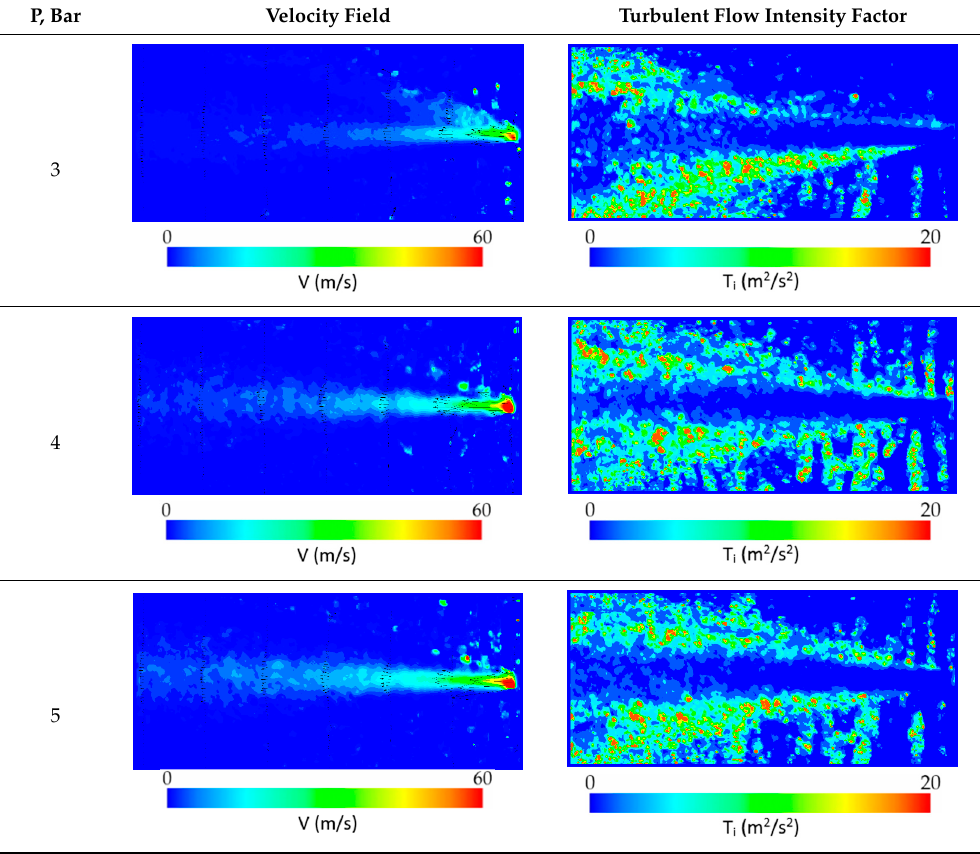
Table 4. Influence of pressure P supplying the nozzle on the character of velocity and turbulent flow intensity factor fields for stub regulation angle α = 0°. P, Bar